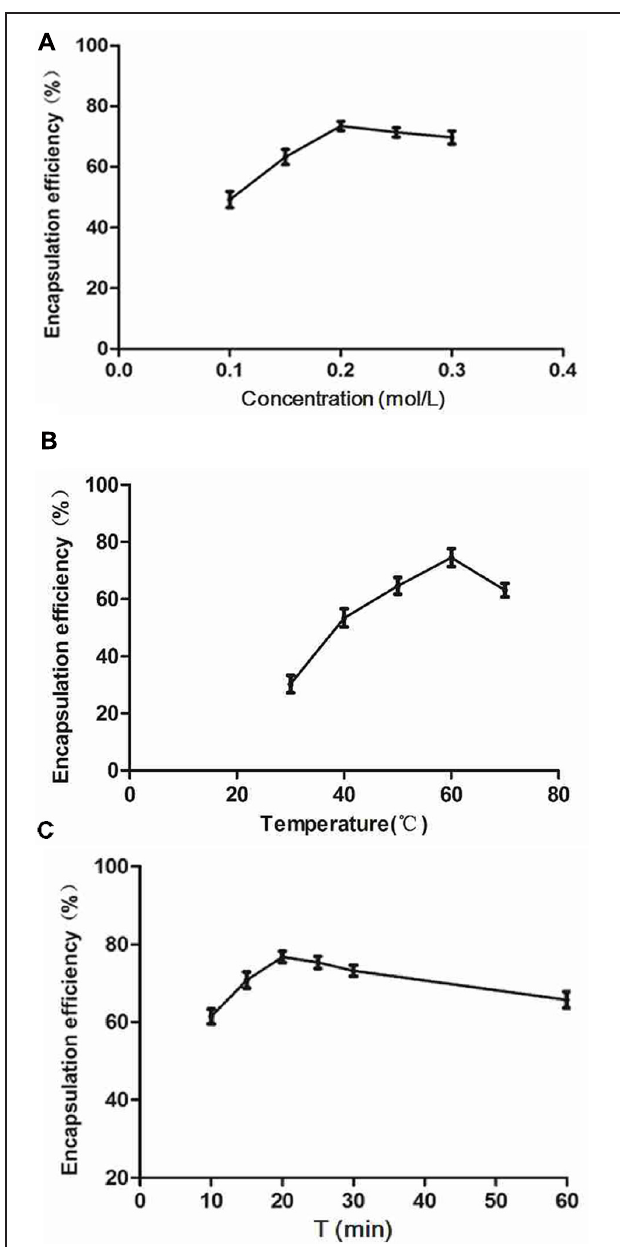
FIGURE 2 | Factors affecting the encapsulation efficiency (EE). The drug-loading experiments were performed using the ammonium sulfate